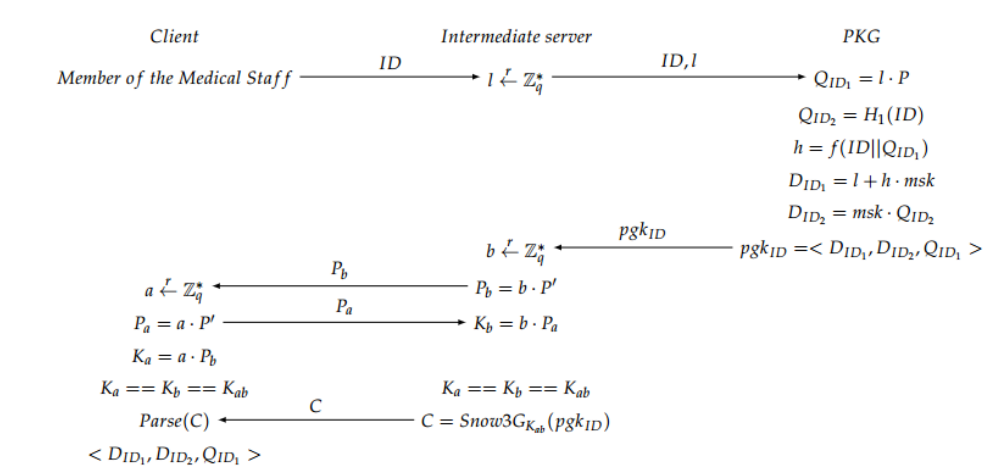
Figure 5. Extract